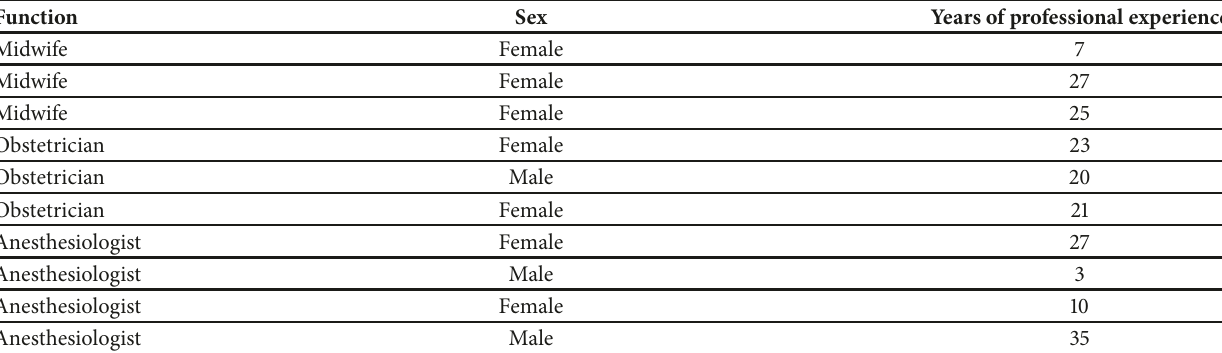
Table 2: Demographic characteristics of